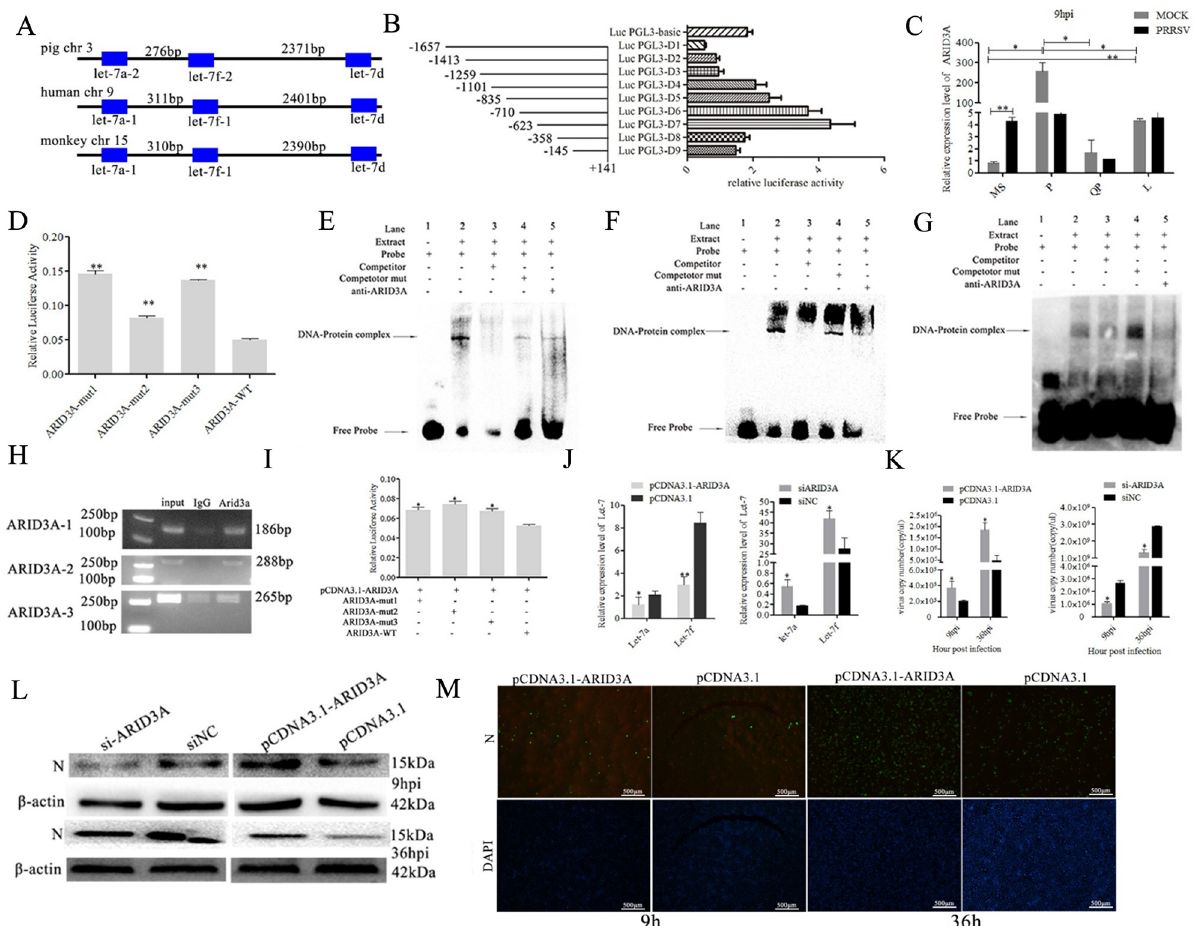
Fig 5. ARID3A binds to the promoters of let-7 and regulates let-7 expression and PRRSV-2 replication. Let-7a-2/let-7f-2/let-7d cluster is located on pig chromosome 3 (A). Let-7a-2/let-7f-2/let-7d promoter activity was identified by luciferase assay using truncated reporter constructs in Marc-145 cells (B). Expression levels of ARID3A were analyzed among PRRSV-infected/mock-infected PAMs from 4 pig breeds at 9 hpi by RT-qPCR (C). A mutation in the ARID3A binding site of let-7a-2/let-7f-2/let-7d promoter strongly increased transcriptional activity (D). The probes were incubated with nuclear extracts of PAMs in the absence or presence of a 50-fold excess of various competitor DNA oligos (mutant or unlabeled probes) or antibodies. The specific DNA–protein complex bands are indicated by arrows (E-G). ChIP assay results showed the interaction of ARID3A with the let- 7a-2/let-7f-2/let-7d promoter in vivo in PAMs. DNA isolated from immunoprecipitated material was amplified by PCR for 35 cycles. Total chromatin was used as the input. Normal rabbit IgG was used as the negative control (H). The dual luciferase reporter assay was used to detect the luciferase activity in Marc-145 cells co-transfected with pcDNA3.1-ARID3A and ARID3A-mut1, ARID3A-mut2, ARID3A-mut3 or ARID3A-WT (I). Marc-145 cells were transfected with pCDNA3.1-ARID3A or siARID3A to detect the expression of let-7a/let-7f (J). Marc-145 cells were transfected with pCDNA3.1-ARID3A or siARID3A and then infected with PRRSV-2 to detect the replication of PRRSV-2 (K, L). Immunofluorescence assay of PRRSV- 2 N protein was performed in Marc-145 cells transfected with pcDNA3.1-ARID3A or pcDNA3.1 and infected with PRRSV-2 for 9 h, 36 h (M). Three independent experiments were carried out. Error bars stand for the mean ± SD of at least triplicate experiments, � p < 0 . 05 , �� p < 0 . 01 . plasmids was significantly ( p < 0 . 05 ) higher than that without mutation (Fig 5I). Furthermore,